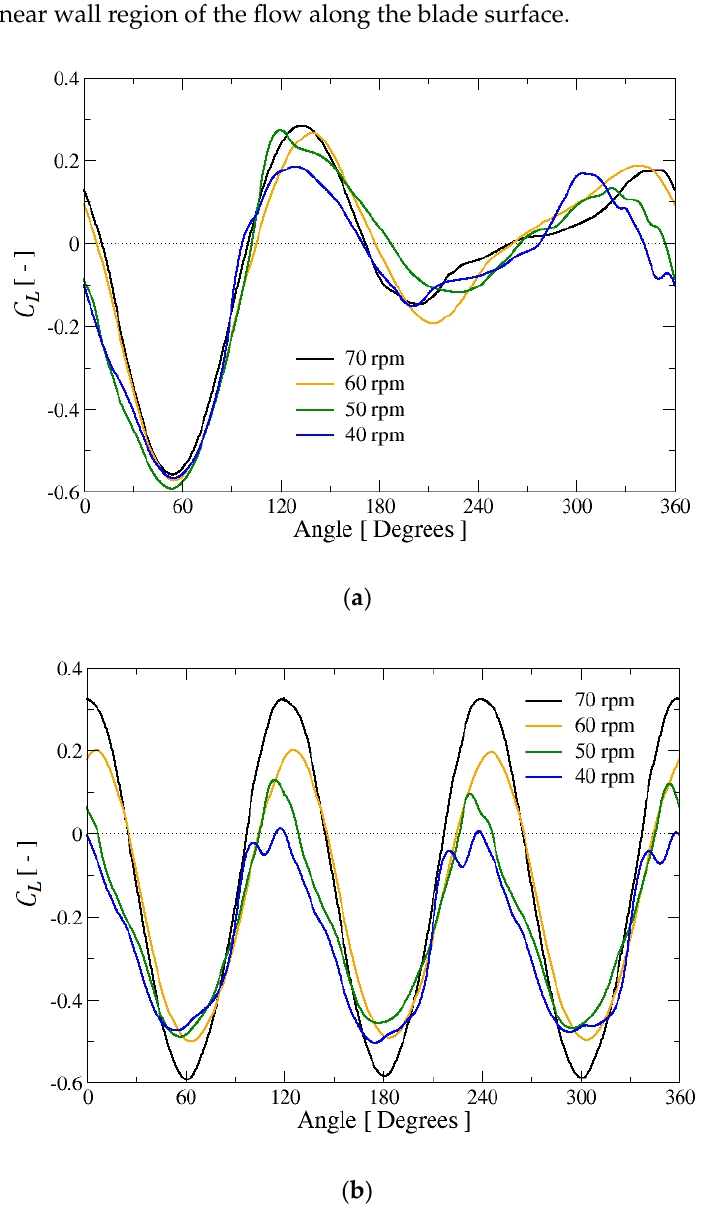
Figure 7. Lateral force coe ffi cient evolution along a revolution for di ff erent values of λ . ( a ) Single blade and ( b ) three blades.